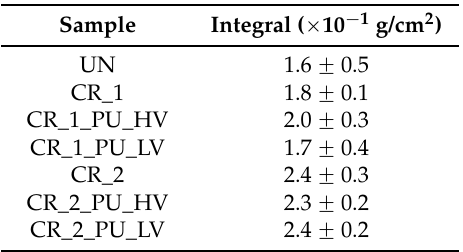
Table 3. Water profile integrals ( ˆ 10 ´ 1 g/cm 2